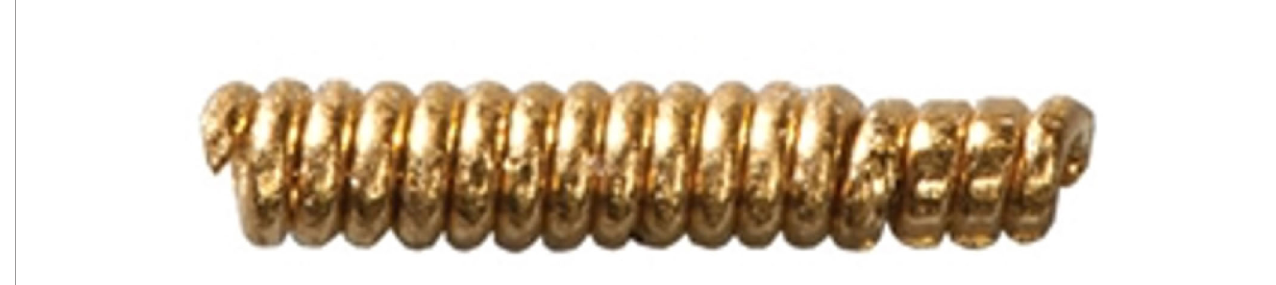
TABLE 1 | Patient demographic information.